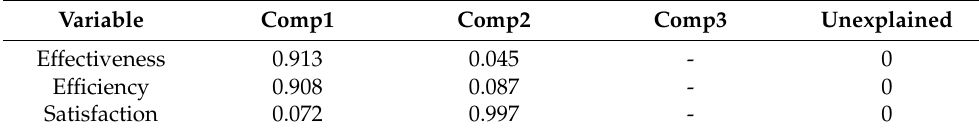
Table 6. The rotated component matrix between effectiveness, efficiency, and